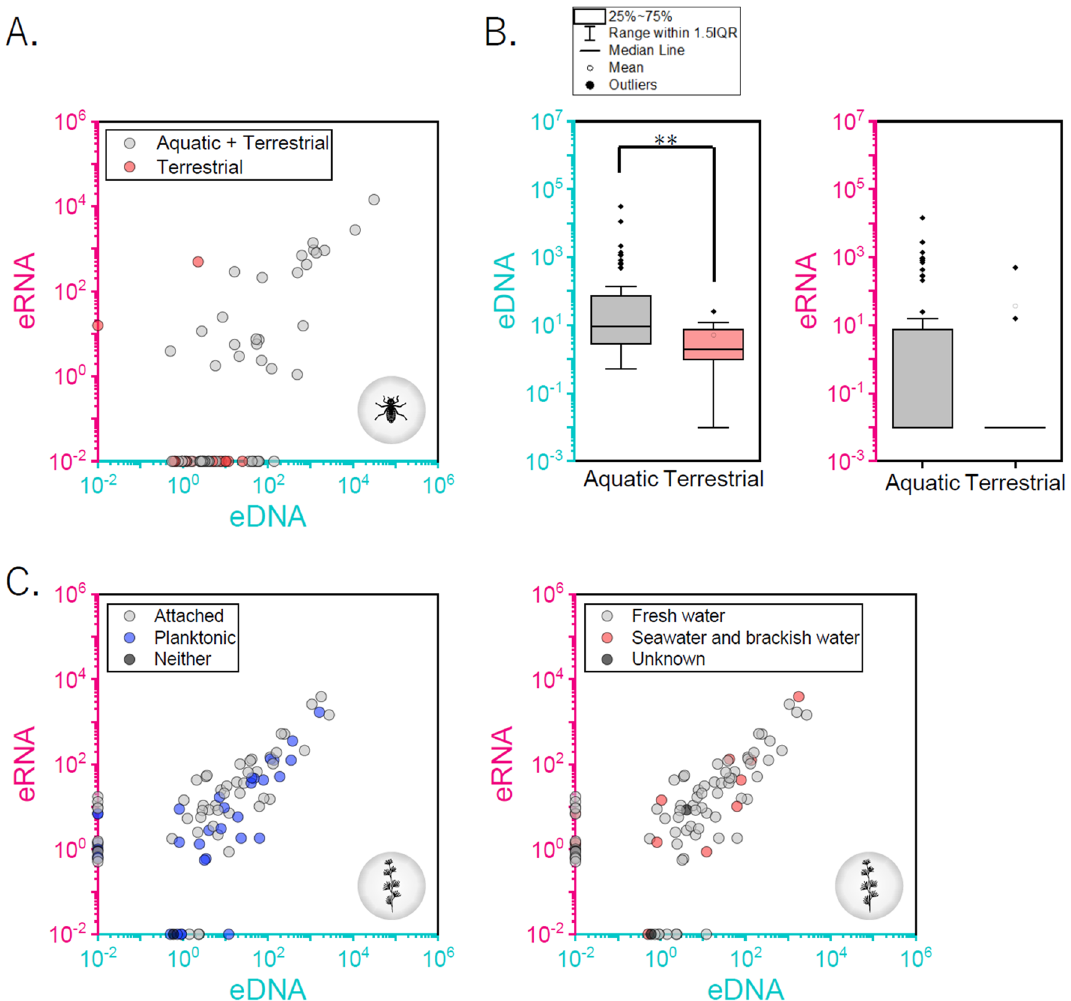
Figure 6. Ecological trait evaluation using eDNA/eRNA metabarcoding analyses to identify false positives. ( A ) Scatter plot between eRNA and eDNA read numbers for arthropods and species’ habitat. ( B ) Differences in eDNA/eRNA read numbers between aquatic and terrestrial arthropods. ( C ) Scatter plot between eRNA read numbers and eDNA read numbers in algae and ecological traits related to false positives, (Left) attached or planktonic (Right) fresh water or seawater and brackish water. **p <